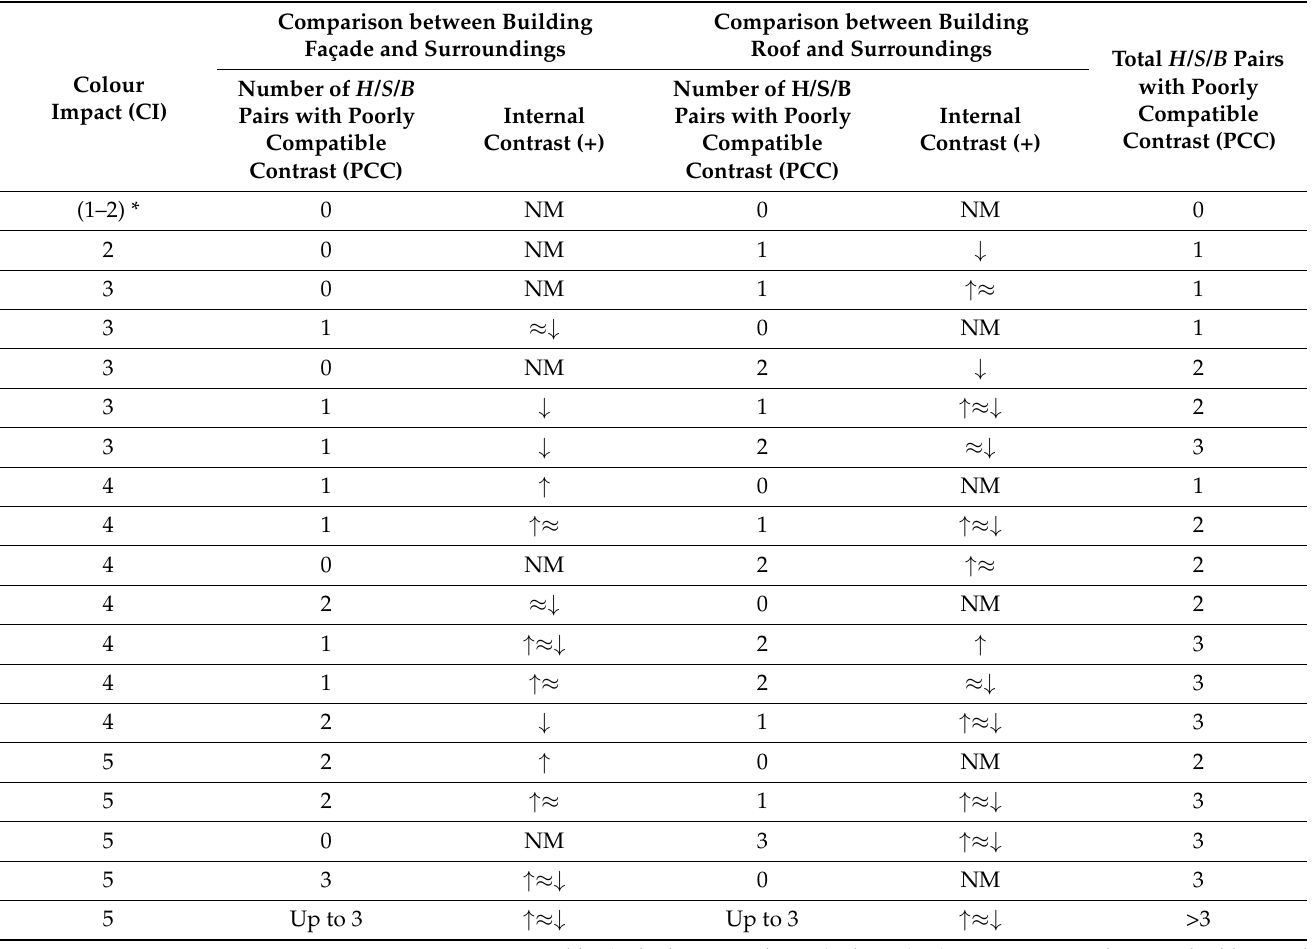
Table 2. Assessment of colour impact